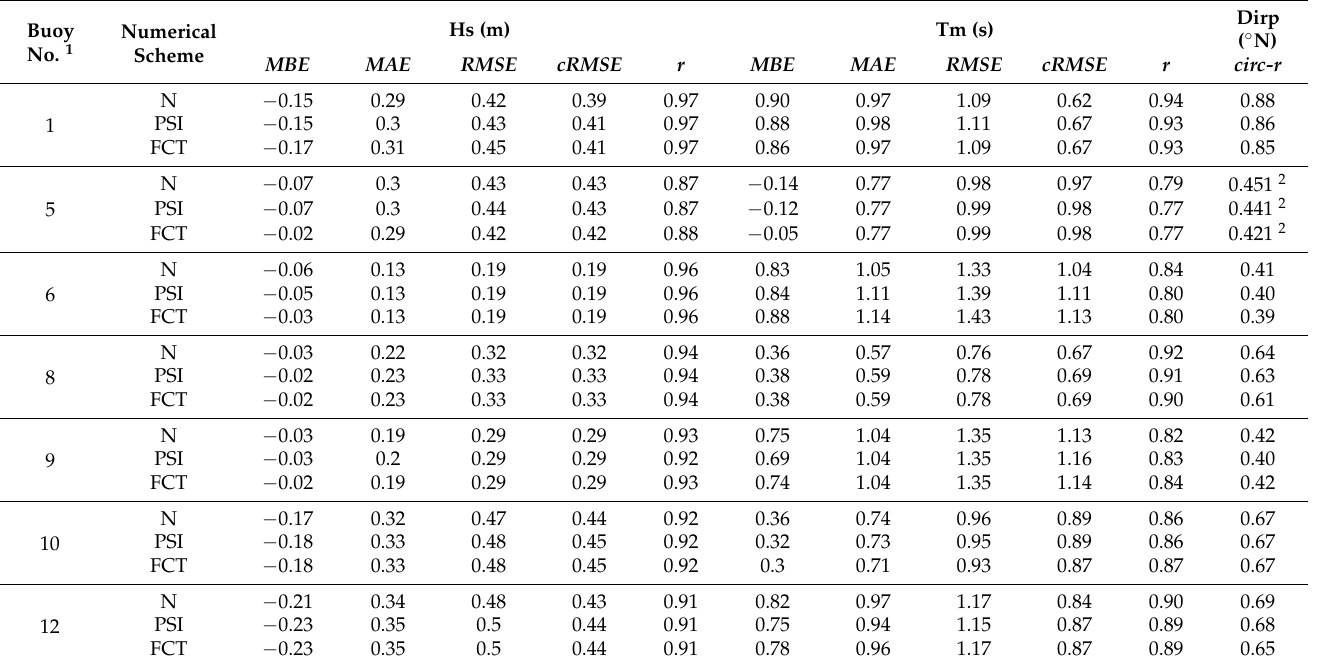
Table 6. Statistical indicators for Hs, Tm and Dirp (or Dirm), evaluated for explicit N, PSI and FCT numerical schemes, with ST4 source term parameterization and 60 s time step. Buoy Numerical No. 1 Scheme